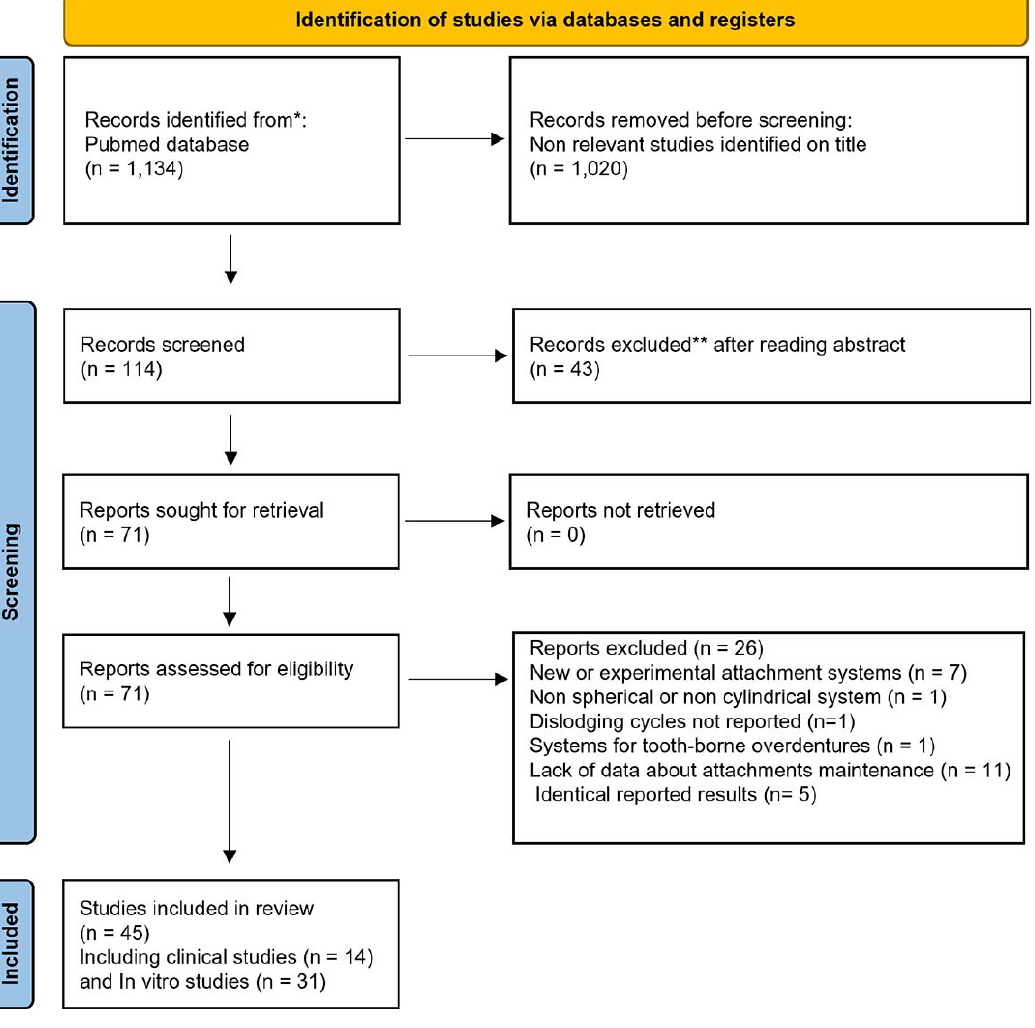
Figure 2. Search method for identification of studies using PRISMA guidelines for systematic reviews.